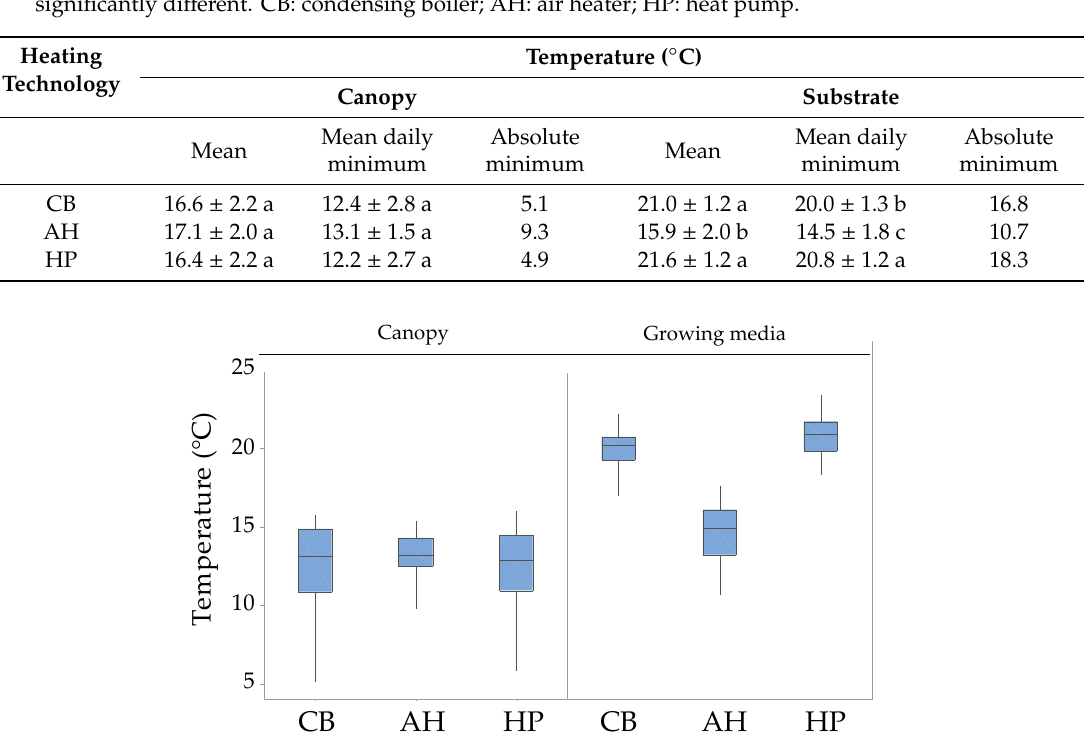
Table 5. Main measured temperatures inside canopy and inside growing media for the three heating systems. Data are expressed as average ± standard deviation. Means that do not share a letter are significantly different. CB: condensing boiler; AH: air heater; HP: heat pump.